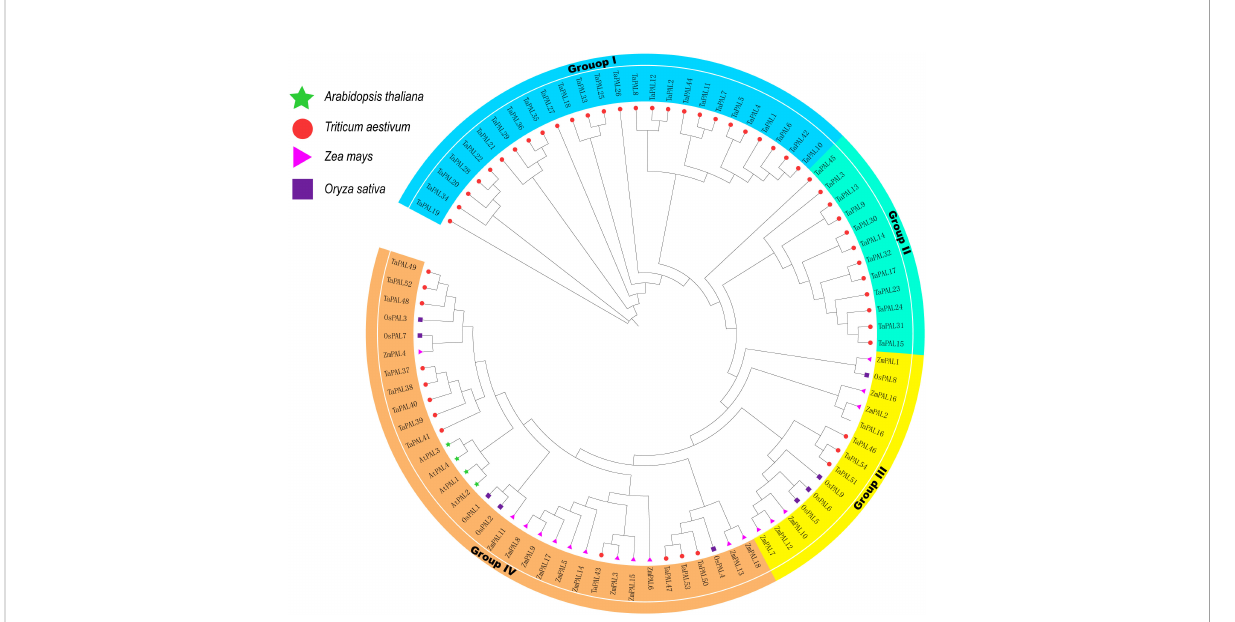
FIGURE 1 Phylogenetic relationship of TaPALs, OsPALs, AtPALs, and ZmPALs. Protein sequences were aligned using ClustalW2 sequence alignment program and the phylogenetic tree was constructed by software MEGA7 used to create Maximum Likelihood (ML) under the LG model. The tree was constructed with 1,000 bootstrap replications. Different groups were marked by different colors, and the PAL from wheat, rice, maize, and Arabidopsis were distinguished with different color and shape.